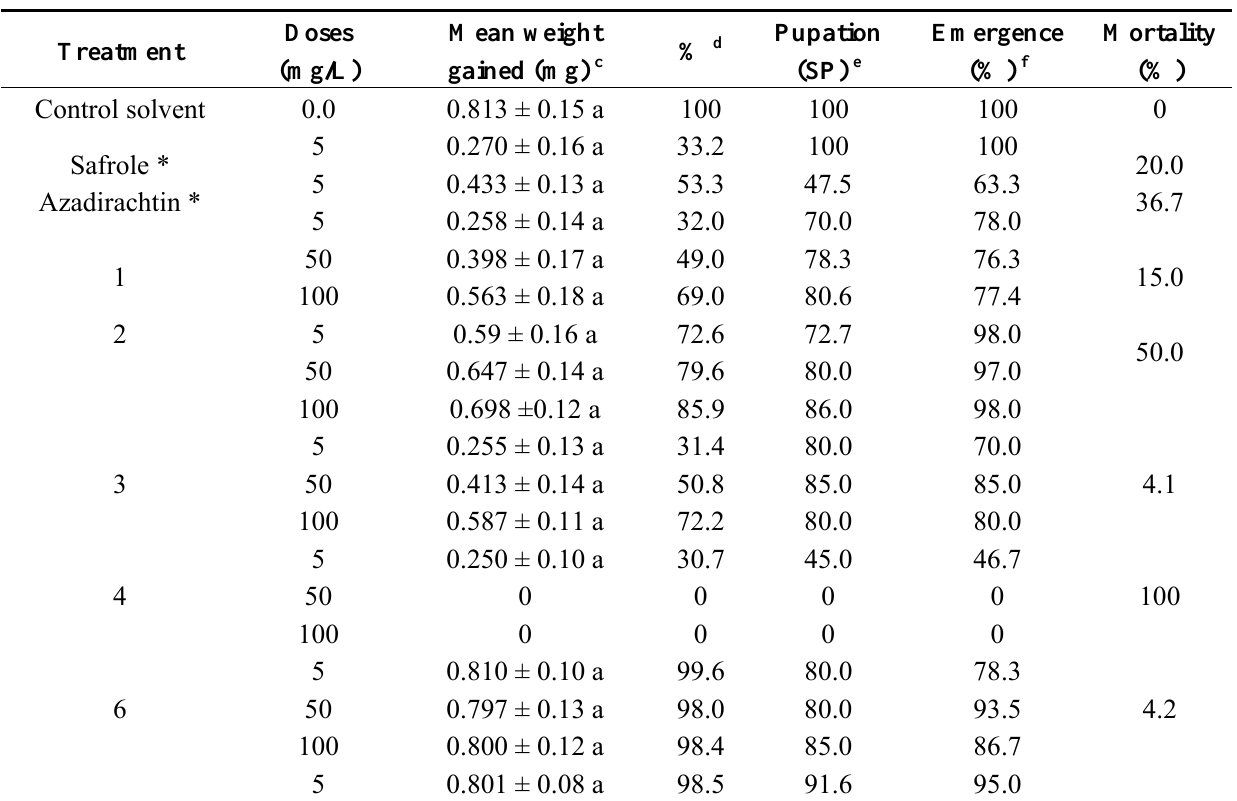
Table 4. Activities of compounds isolated from Drimys winteri F., compared with derivative compounds in this